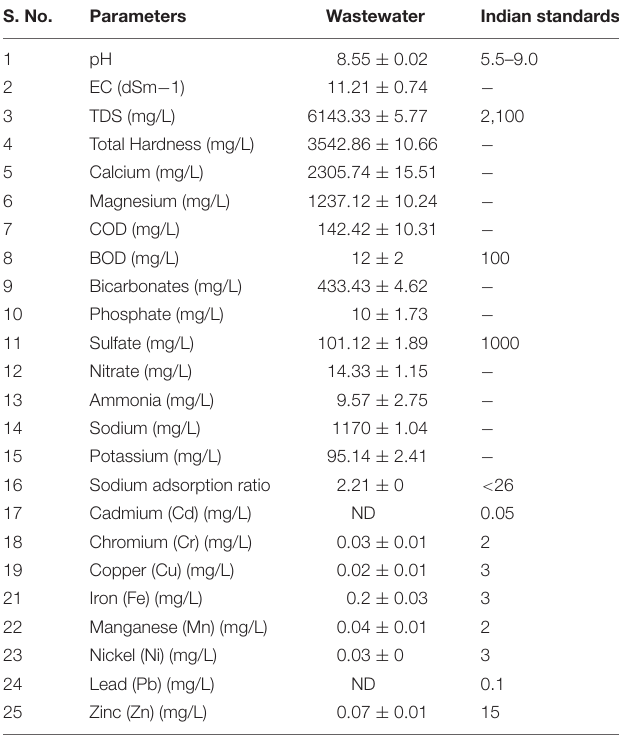
TABLE 3 | Initial physicochemical characterization of moderately saline wastewater.